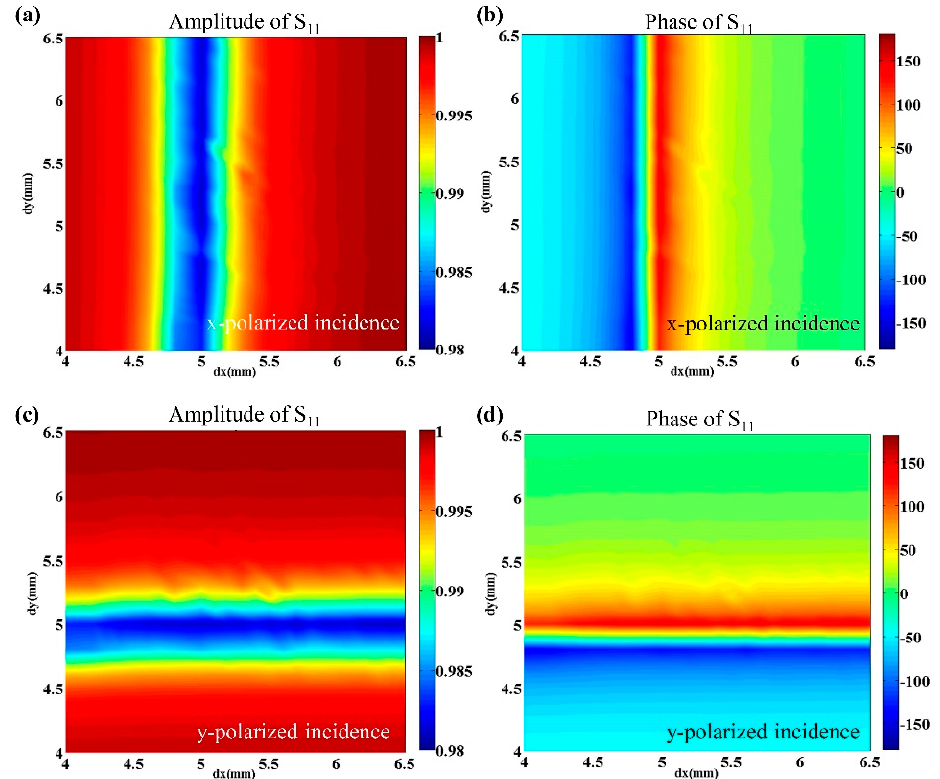
Figure 2. Simulated reflective coefficient S 11 of the unit cell. The ( a ) amplitude and ( b ) phase of S 11 under x -polarized incidence as functions of dx and dy. The ( c ) amplitude and ( d ) phase of S 11 under y -polarized incidence as functions of dx and dy.